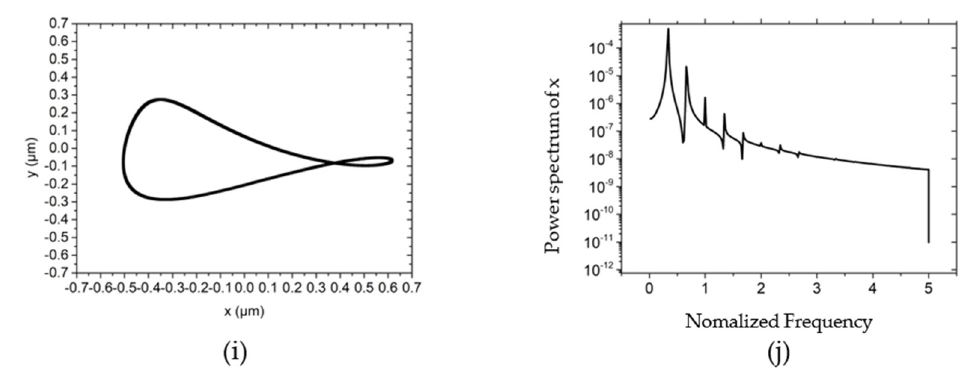
Figure 8. The influence of different rotor mass on rotor trajectory and power spectral density at w = 50,000 r/min, Fy = 30 N, m u = 0.1 g, m = 90 g. ( a ) Rotor center trajectory ( m u = 0), ( b ) Power spectral density in the x direction ( m u = 0), ( c ) Rotor center trajectory ( m u = 0.2), ( d ) Power spectral density in the x direction ( m u = 0.2), ( e ) Rotor center trajectory ( m u = 0.3), ( f ) Power spectral density in the x direction ( m u = 0.3), ( g ) Rotor center trajectory ( m u = 0.4), ( h ) Power spectral density in the x direction ( m u = 0.4), ( i ) Rotor center trajectory ( m u = 0.5), ( j ) Power spectral density in the x direction ( m u = 0.5).